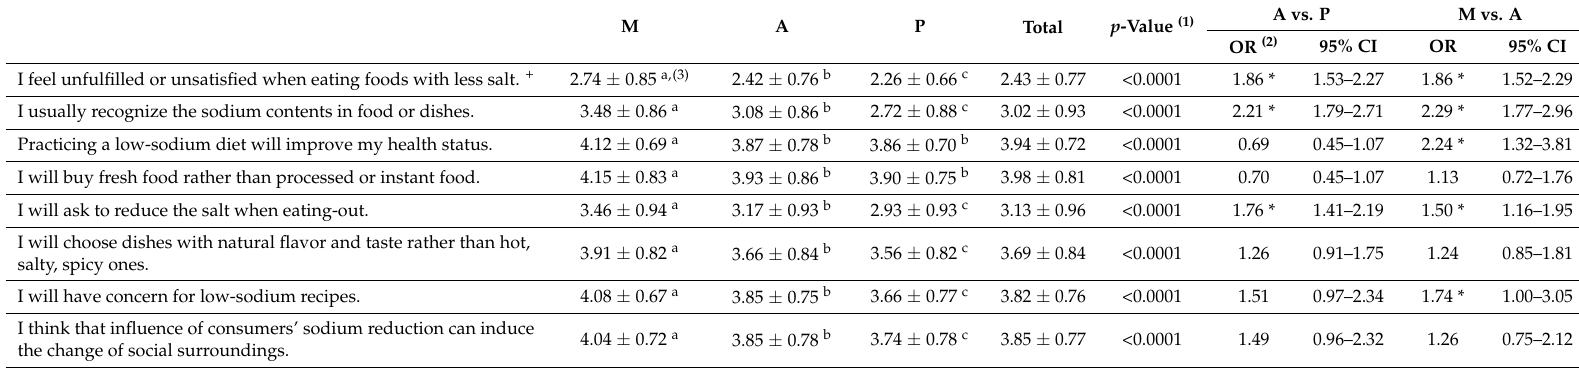
Table 4. Perceptions and self-efficacy of reducing sodium intake according to the stages of